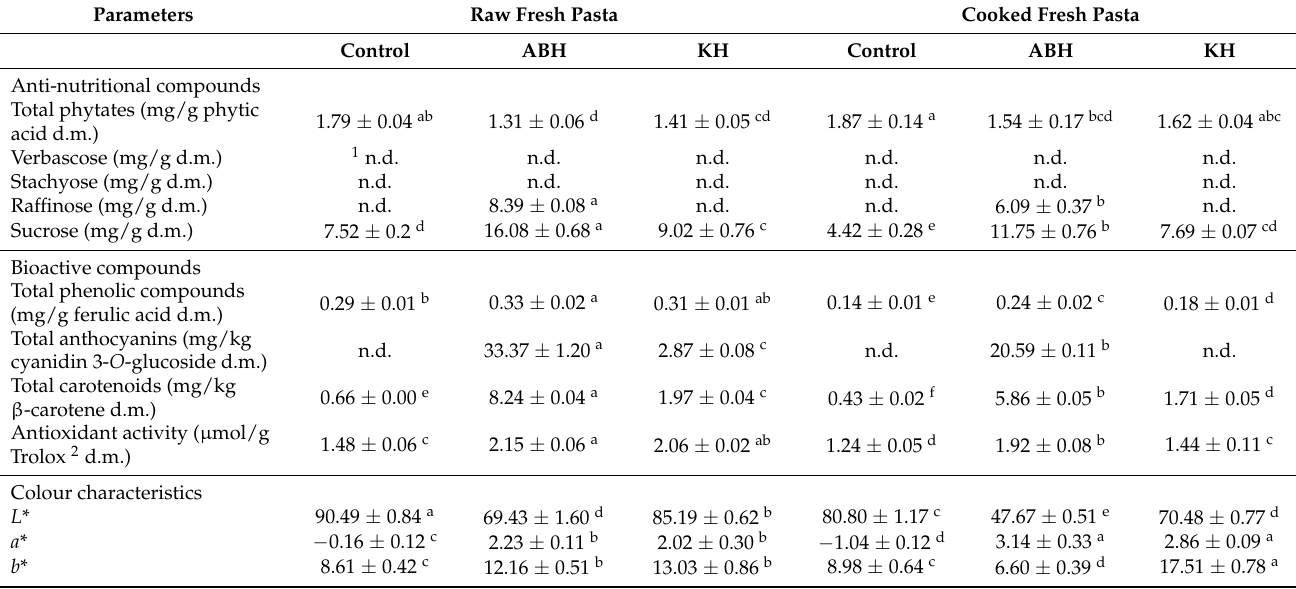
Table 3. Anti-nutritional and bioactive compounds, antioxidant activity, and colour parameters of raw and cooked GF fresh pasta enriched with 8 g/100 g of Apulian black (ABH) and kabuli (KH) chickpea hull, compared to control pasta (mean value ± standard deviation; two-way ANOVA was applied).